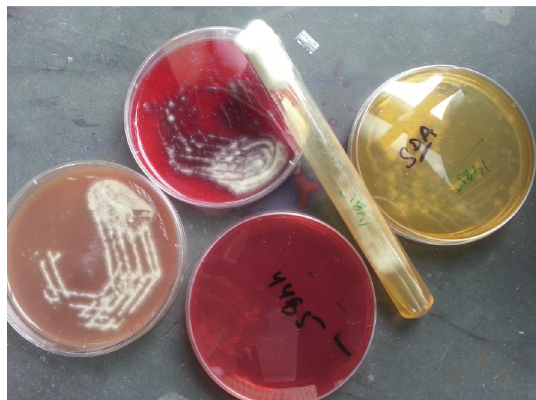
Figure 3: Aliquots from the culture sample grown on CHOC, BAP, MAC, and SDA media indicate the growth of Aspergillus spp.